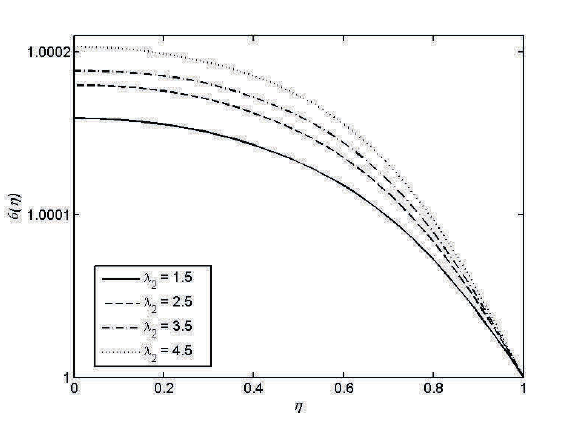
Fig. 11: Variation of non-dimensional temperature with η for differ- ent values of λ 2 for λ 1 = 5, Pr = 12 and M =